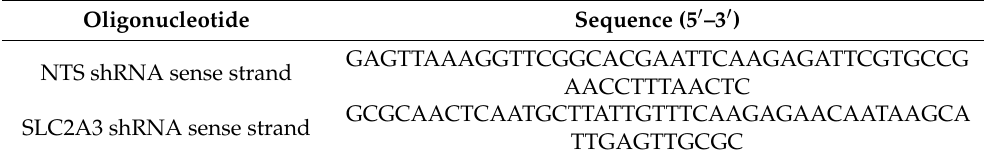
Table 6. Non-targeting sequence (NTS) RNAi and SLC2A3 RNAi shRNA sequences.